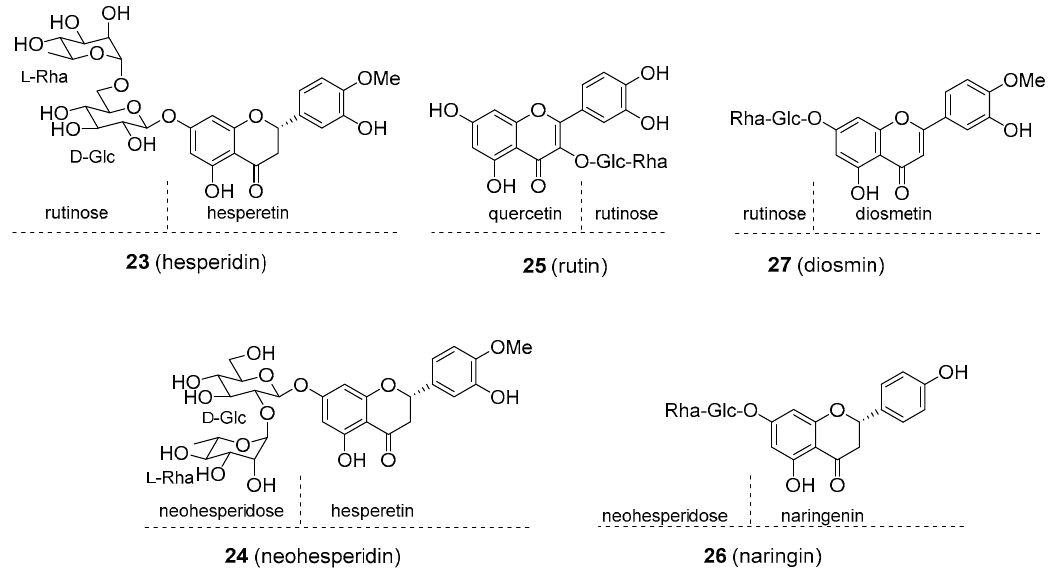
Figure 5. Molecular structures of some of the glycosylated flavonoids.